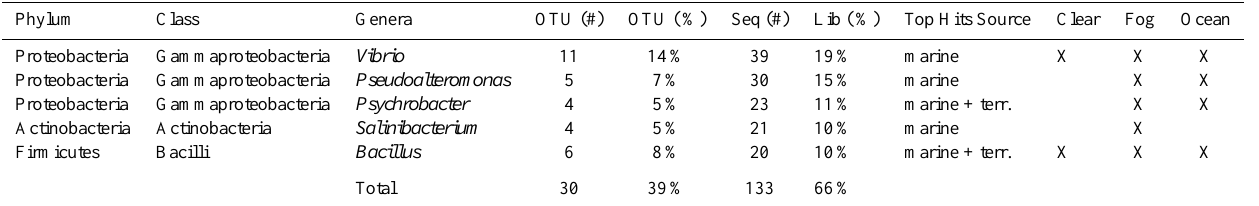
Table 2. Dominant ( ≥ 5% of total library) genera in this study’s combined library (ocean surface + aerosols), coastal Maine, USA. OTU (#) refers to the total number of OTU’s found within that genus. OTU (%) is the percentage of the total OTU’s ( n = 76) found in the combined libraries. Seq (#) is the number of total sequences assigned to that genus. Lib (%) is the percentage of the entire sequence library assigned to that genus. Top Hits Source refers to the source most common among all sequences in that genus (terr. = terrestrial). An “X” indicates the presence of this genus in the clear, fog, and/or ocean